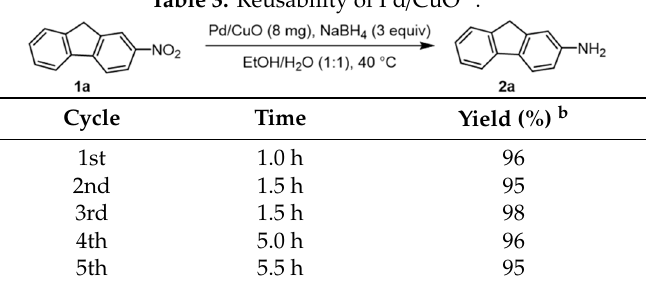
Table 3. Reusability of Pd / CuO a .